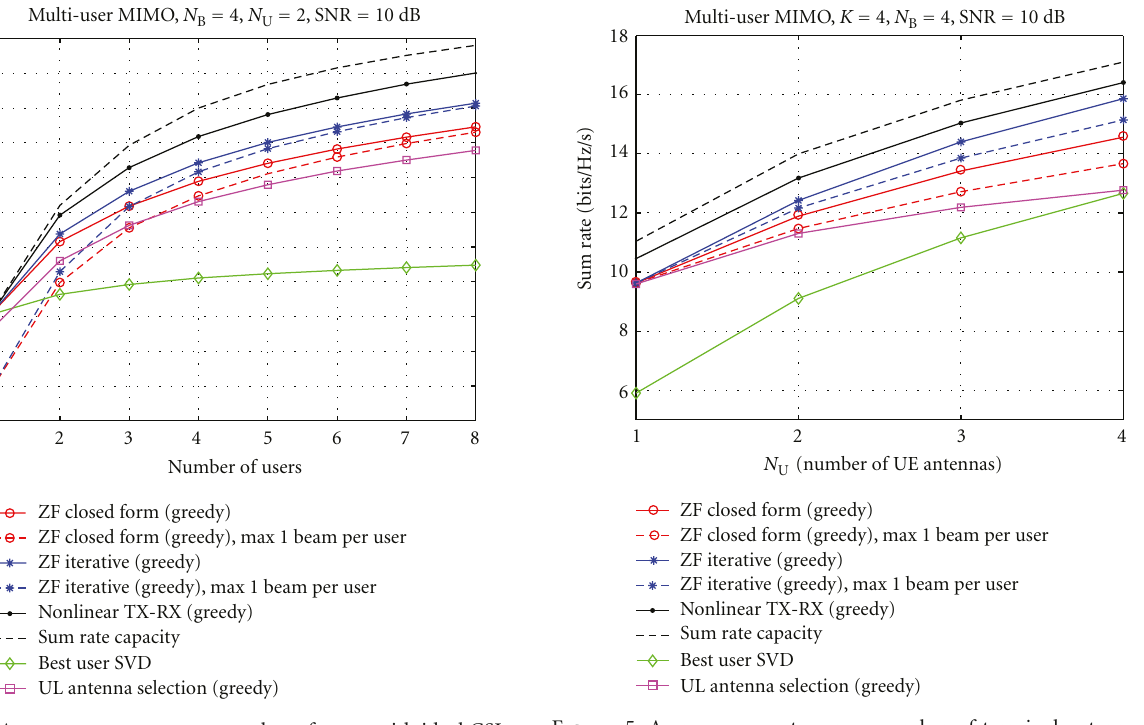
Figure 4: Average sum rate versus number of users, with ideal CSI, N B = 4, N U = 2, D S = 0.